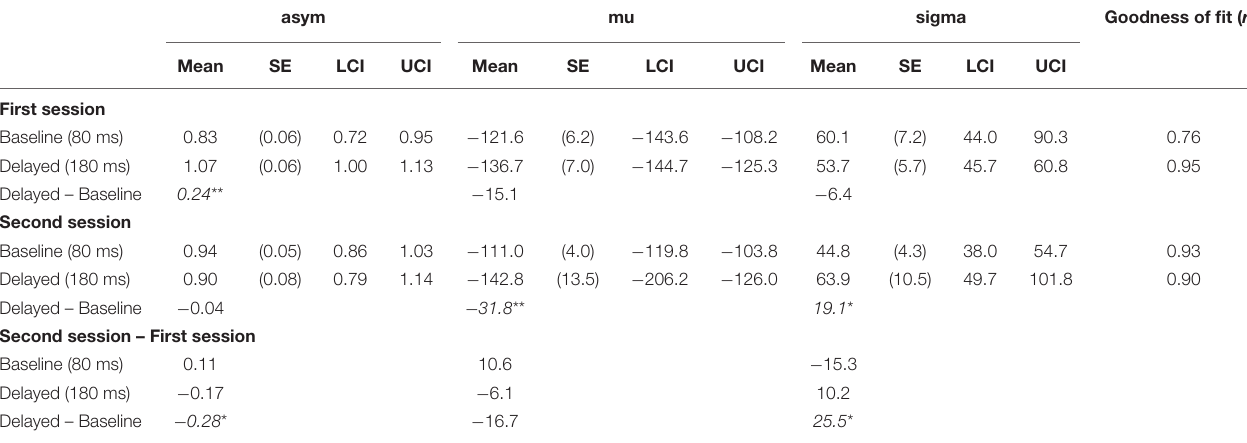
FIGURE 4 | Results from the analysis on a trial-by-trial basis about the simultaneity judgment (SJ) data under the computer-controlled trials against the mean asynchrony. (A) Scatter plots of the raw SJ data against the mean asynchrony that is pooled across participants for each condition in two sessions. The probability density of the data is displayed as a curve outside the plot. The mean rate of the “synchronous” responses against the 12 bins of the mean asynchrony is displayed as a circle within the plot. The size of the circle reflects the number of observations in the bin, which is also indicated by the digit below the circle. (B) Fitted Gaussian functions of the SJ against the mean asynchrony for each condition in two sessions. The mean rate of the “synchronous” response against the binned mean asynchrony was also displayed for reference. The size of the circle reflects the number of observations. (C) The asym, mu, and sigma are the parameters of Gaussian representing height, midpoint, and width. (D) Violin plots with boxplots representing the distribution of the estimated parameters from the 18 jackknife replications of the fitting of the Gaussian function to the SJ against the mean asynchrony. TABLE 1 | Estimated parameter values of the fitted psychometric curve of the mean rate of “synchronous” response against the mean asynchrony. asym mu sigma Goodness of fit ( r 2